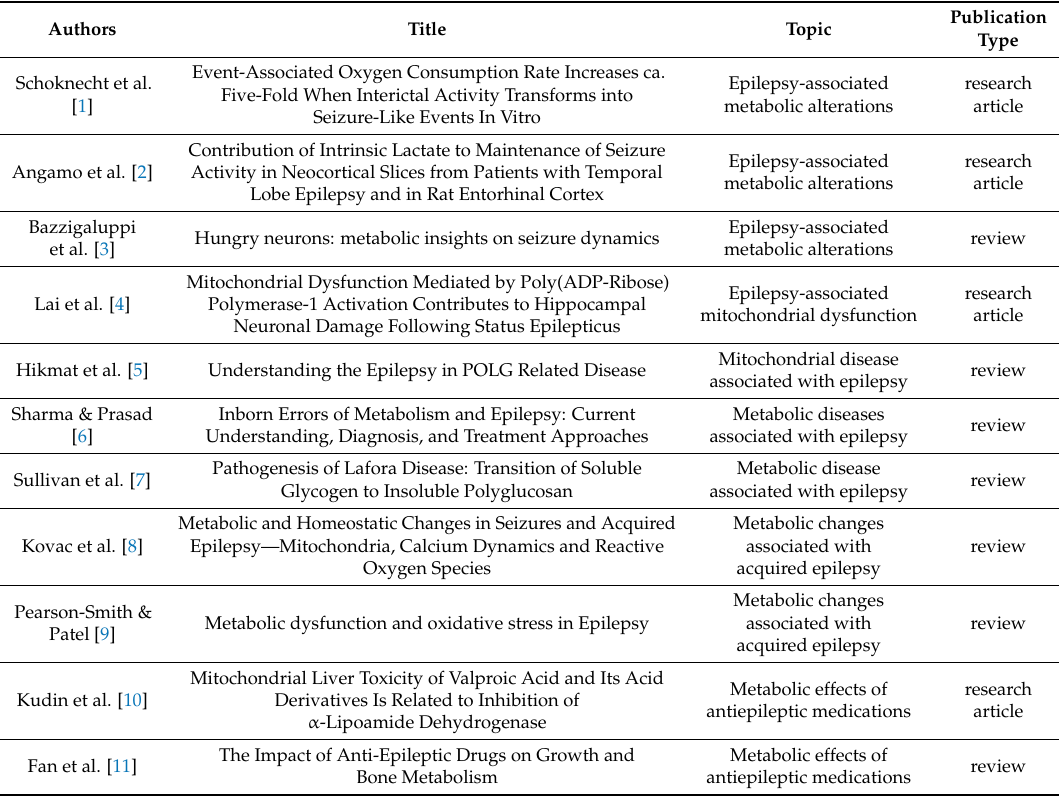
Table 1. Overview of articles published in this special issue entitled “Metabolic